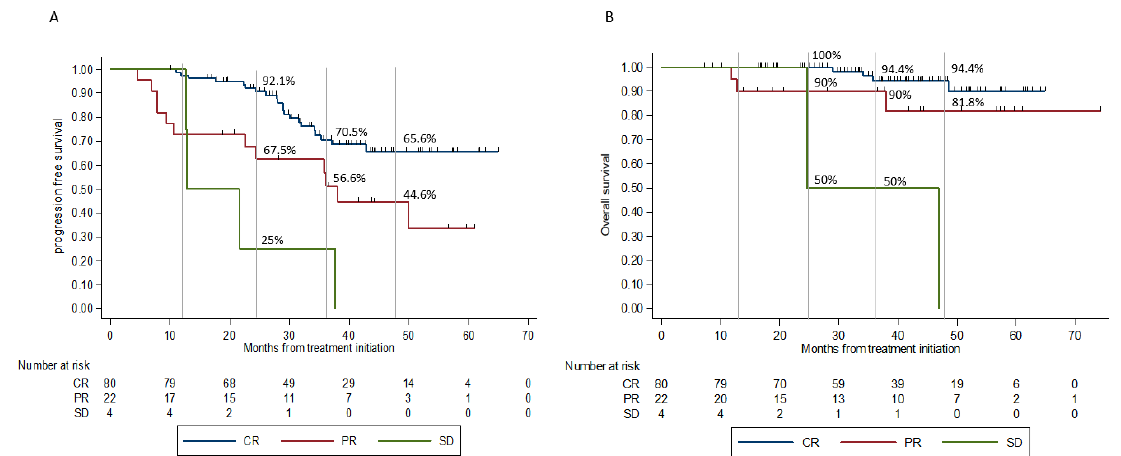
Figure 3. PFS and OS according to best response. ( A ) Progression-free survival according to best response. Patients who achieved CR as best response had median PFS NR, whereas patients who achieved PR and SD as best response had median PFS of 36.5 m and 12.8 m, respectively. Compared to patients with CR, the HR for PFS was 2.48 (95% CI 1.22–5.05; p = 0.012) and 7.18 (95% CI 2.42–21.25; p < 0.0001) for patients with PR and SD, respectively. ( B ) Overall survival according to best response. The median OS for patients with CR, PR, and SD was NR, NR, and 24.6 m, respectively. Compared to patients with CR, the HR for OS was 2.79 (95% CI 0.62–12.49, p = 0.179) and 20.32 (95% CI 3.57–115.5, p = 0.001) for patients with PR